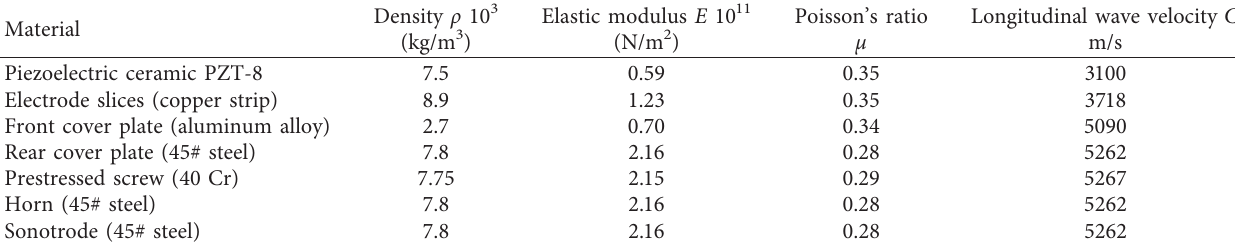
Table 1: Material parameters of ultrasonic